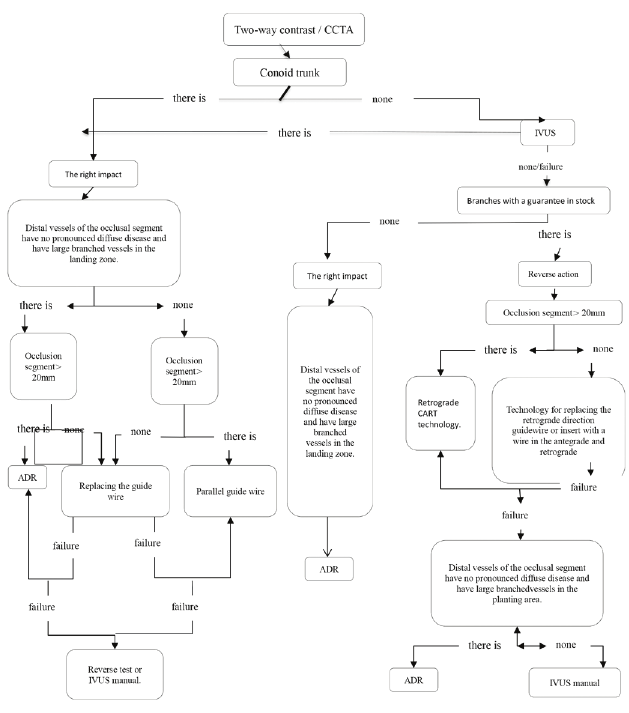
Figure 1 - Proposed road scheme of CTOCQ